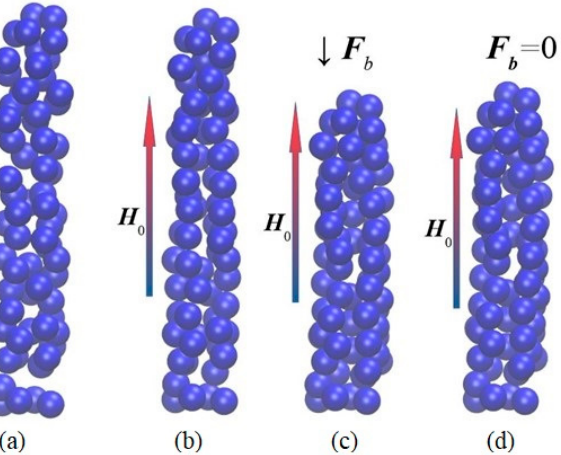
Figure 7. Distribution of the particles in the sample under: ( a )—the external magnetic field strength H 0 = 0 and the end-wall force F b = 0; ( b )— H 0 = 10 G m and F b = 0; ( c )— H 0 = 10 G m , F b = − 6 G m ; ( d )— H 0 = 10 G m and F b = 0. G m denotes the shear modulus of the matrix